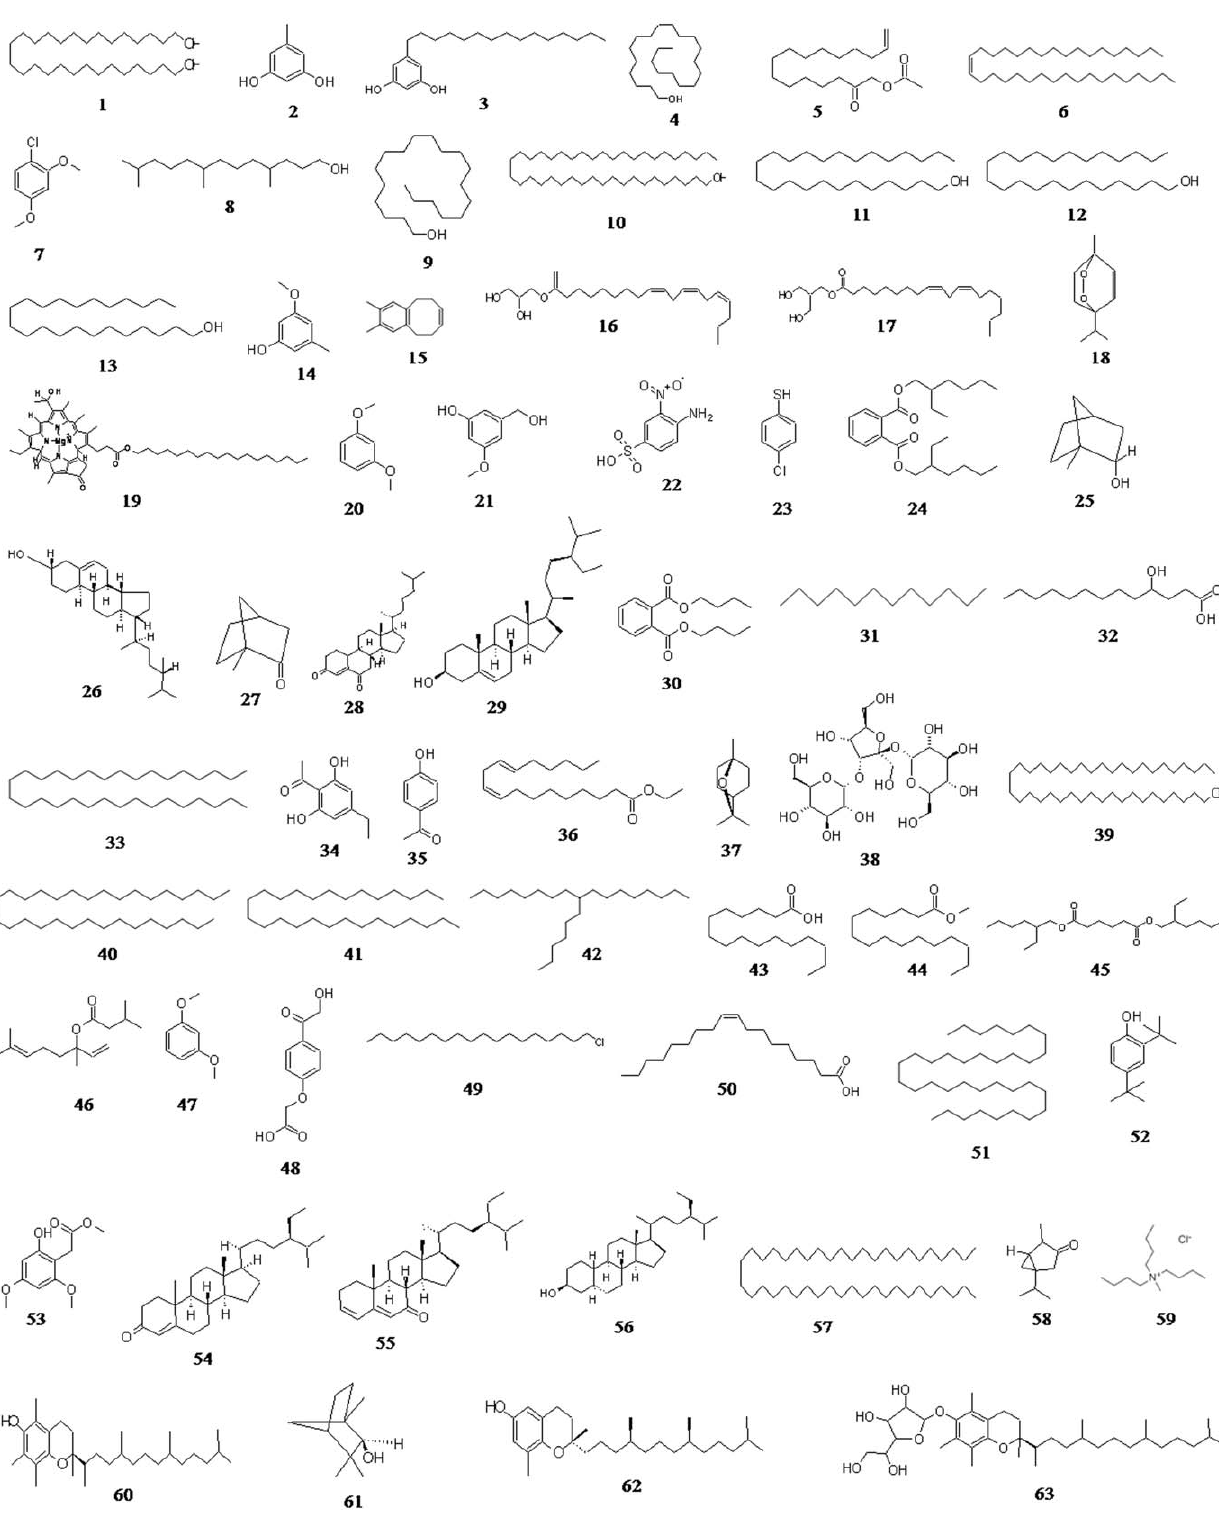
PLOS ONE | www.plosone.org 10 January 2013 | Volume 8 | Issue 1 |